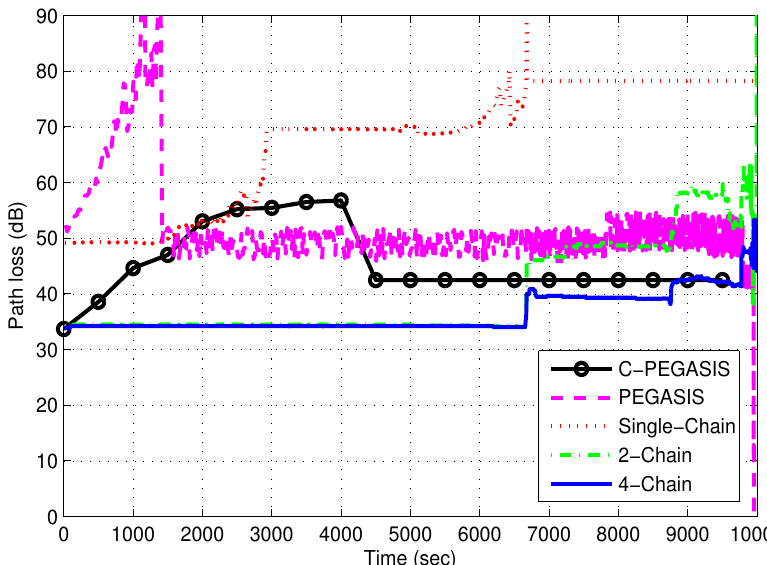
Figure 11. Path loss (dB) in 4-chain, 2-chain, single-chain based routing and PEGASIS.